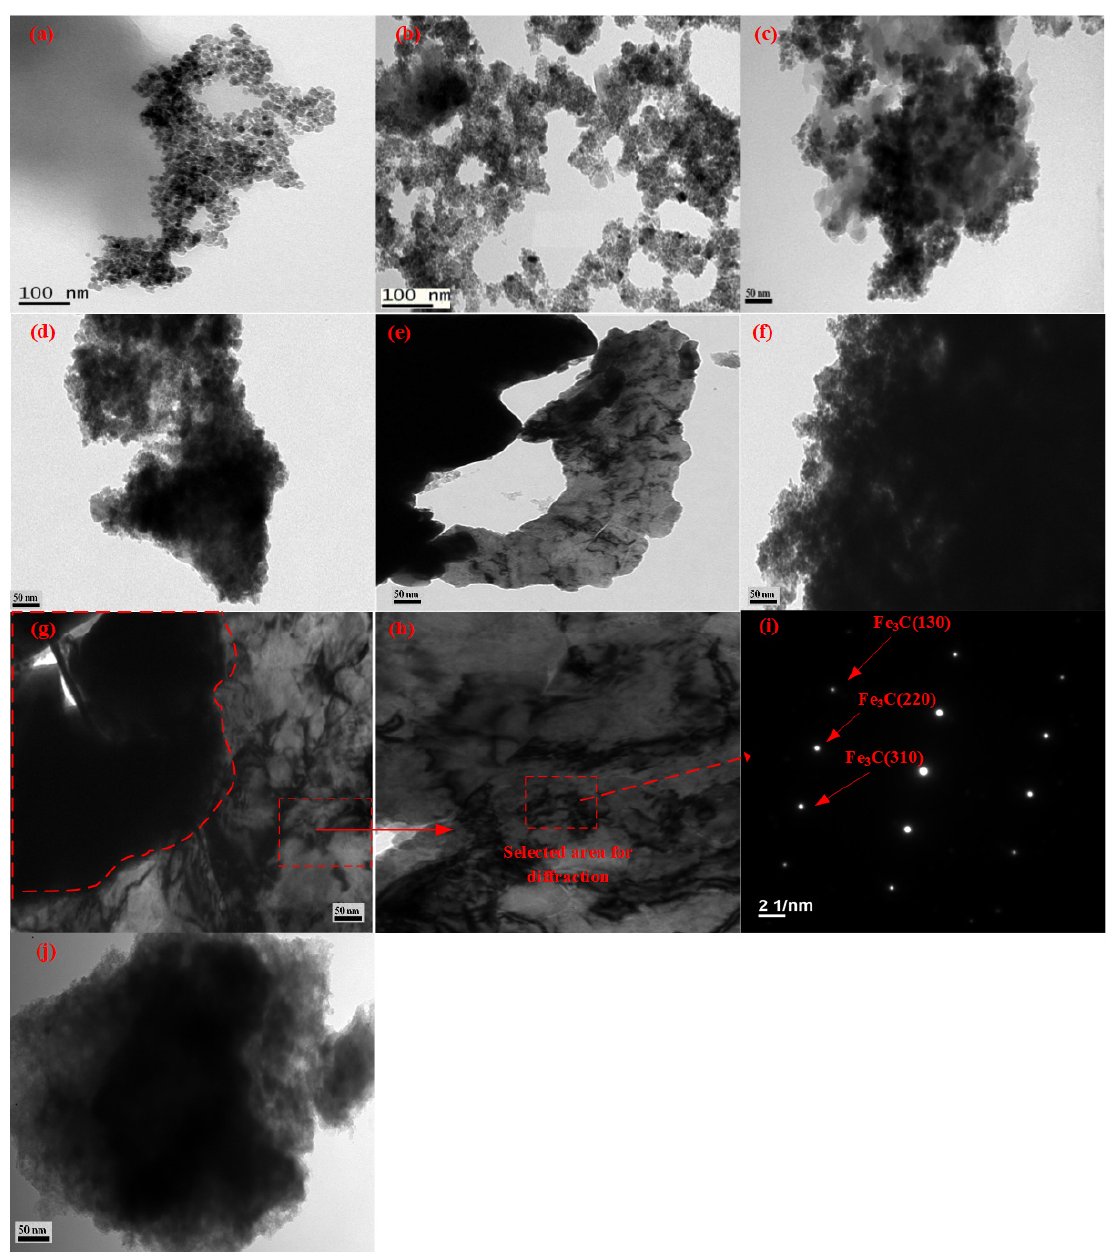
Figure 5. TEM micro-pictures of ( a ) Fe 3 O 4 ( b ) Fe 3 O 4 (OA) ( c ) PANI(EB)/Fe 3 O 4 ( d ) PANI(EB)/Fe 3 O 4 (OA) ( e ) FeNC ( f ) FeNC(OA) ( g ) FeNC-2 ( h ) FeNC-2 (enlarged) ( i ) e-diffraction pattern of vein-like texture ( j ) FeNC(OA)-2.